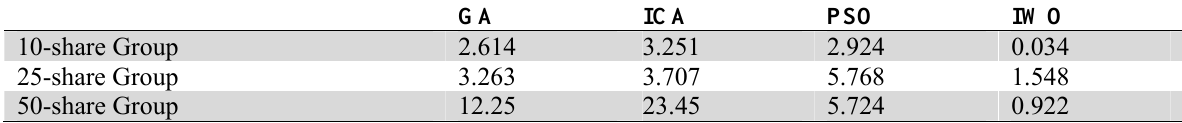
Comparison of average PRD of metaheuristic algorithms